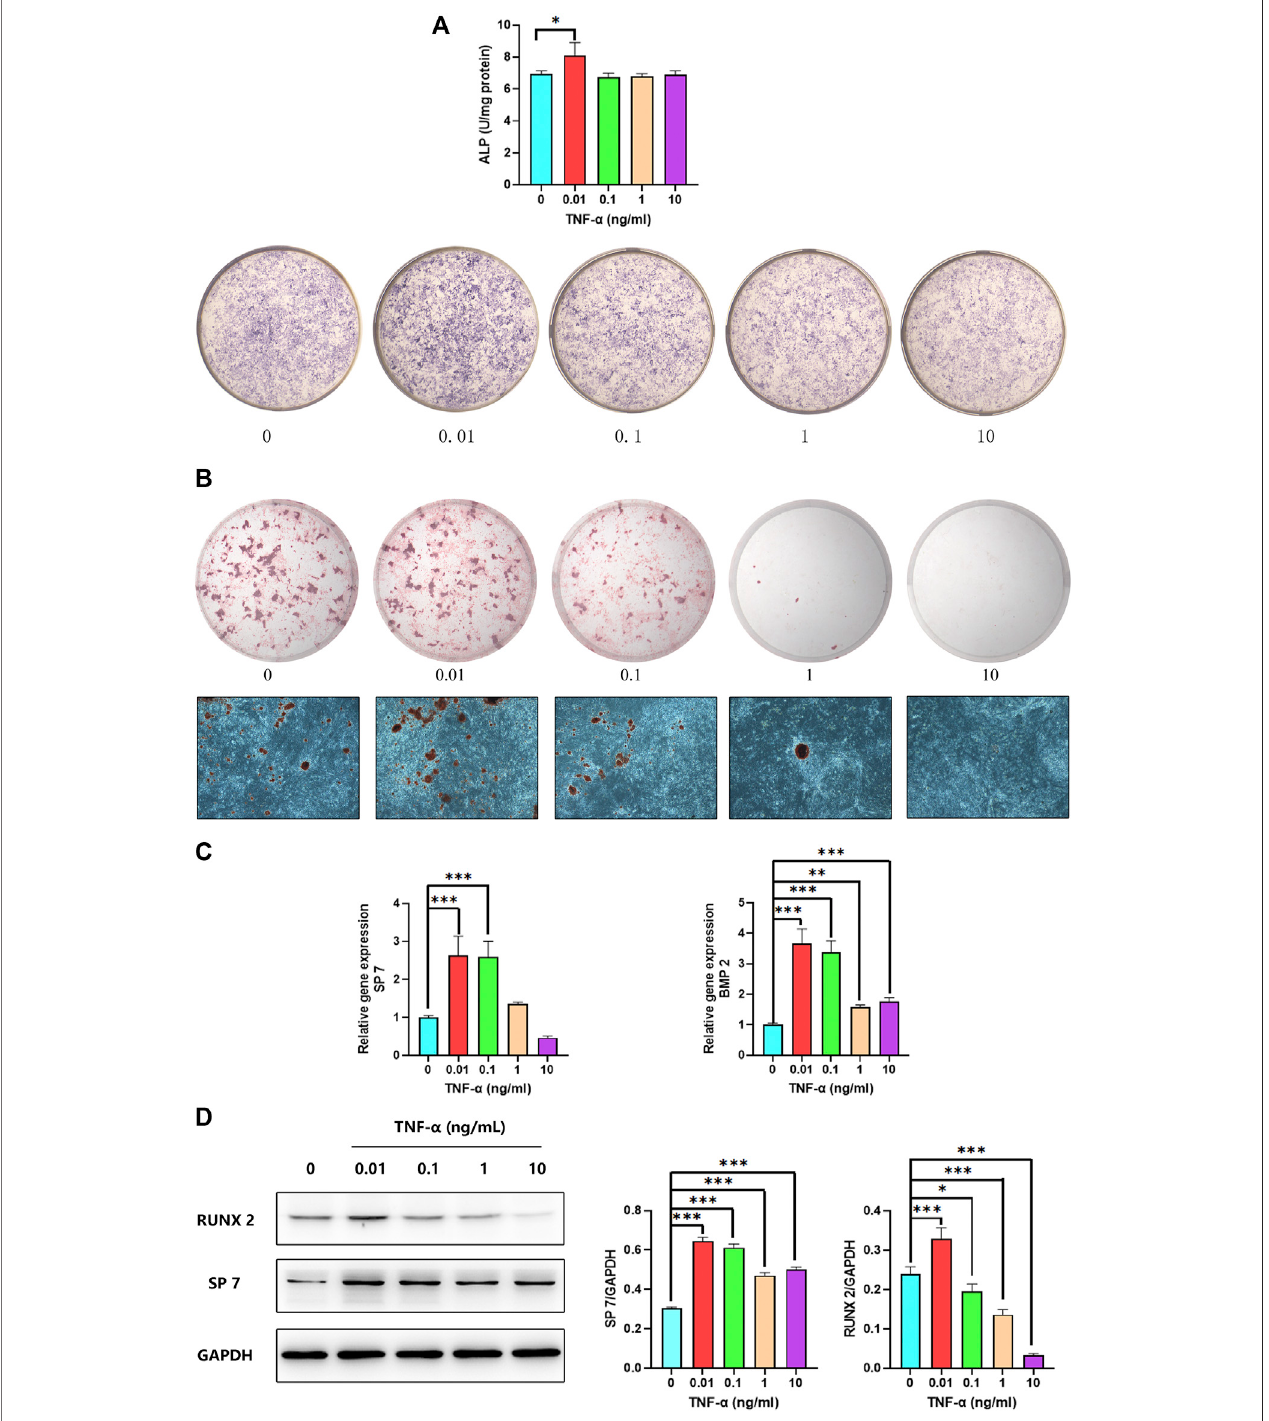
FIGURE 6 | Low concentrations of TNF- α promote osteoblast differentiation. (A) ALP activity and staining of osteoblasts after 7 days of treatment with different concentrations of TNF- α . (B) ARS of osteoblasts on day 30. (C) SP7 and BMP2 mRNA expression in osteoblasts on day 14. (D) RUNX2 and SP7 protein levels on day 14. * p < 0.05, ** p < 0.01, *** p < 0.001 vs. 0 group, n (cid:2) 3.